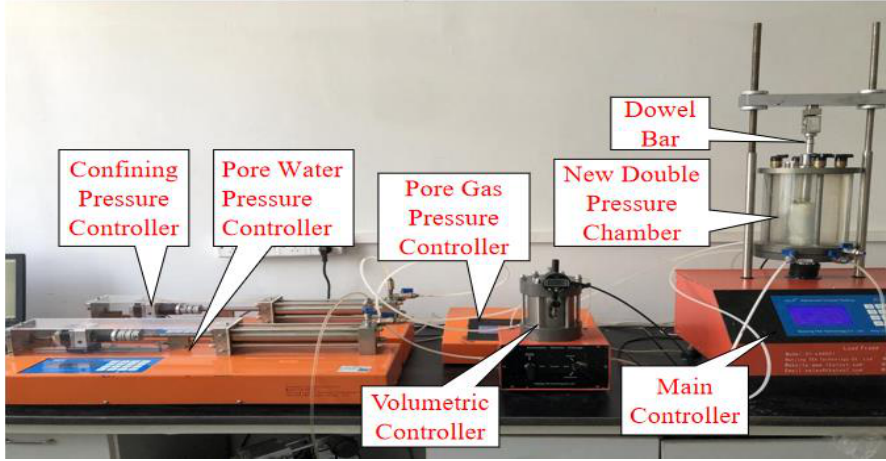
Figure 5. TKA double pressure triaxial apparatus for unsaturated soils.